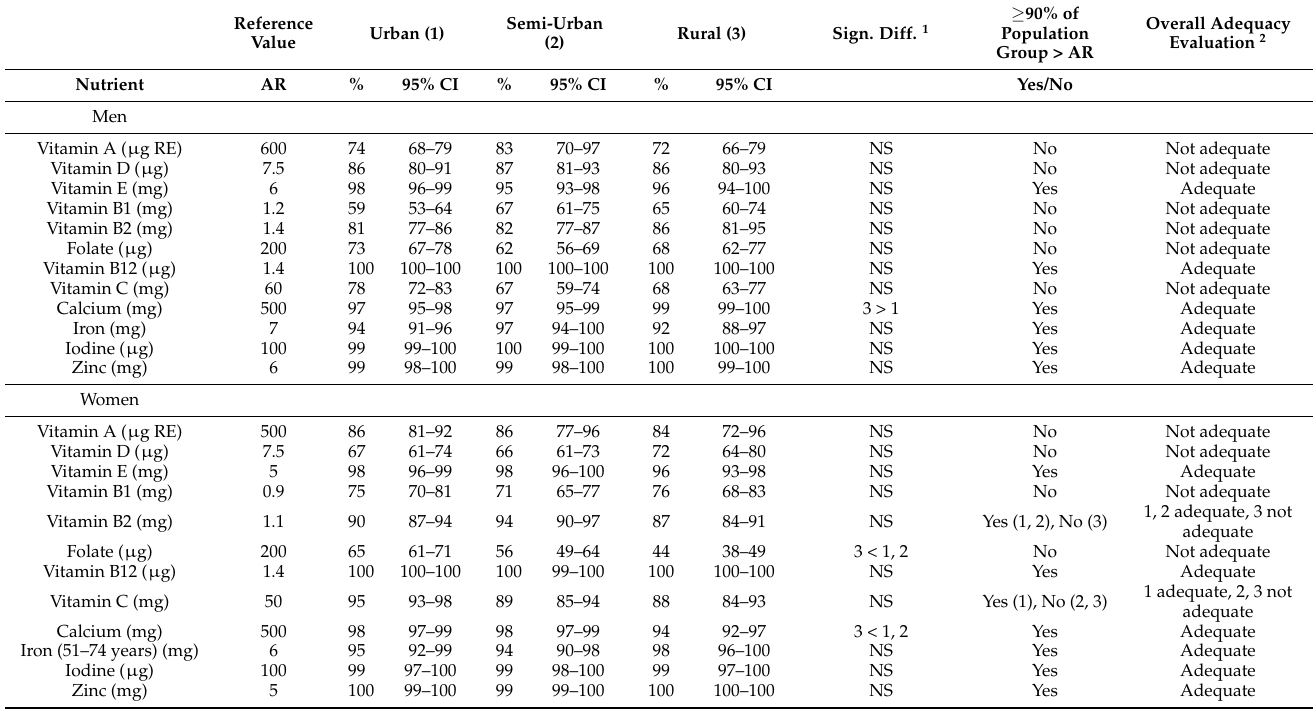
Table 6. Proportion of population groups reaching the average requirement (AR) values, and adequacy evaluation according to usual intake distributions in men and women by urbanisation